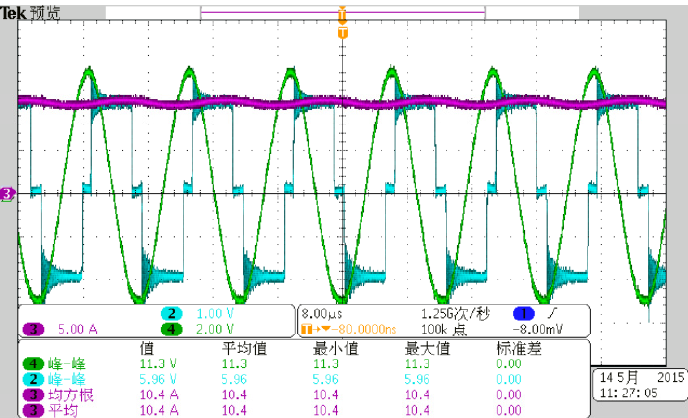
Figure 14. Purple curve: the charging current for the battery pack; cyan curve: the output voltage produced by the H Bridge; green curve: the voltage across the resonant capacitor in the transmitter. They are measured when the system works in the rated state ( V in = 400 V, V B = 309.7 V, P charging = 3220 W, D transfer = 20 cm).